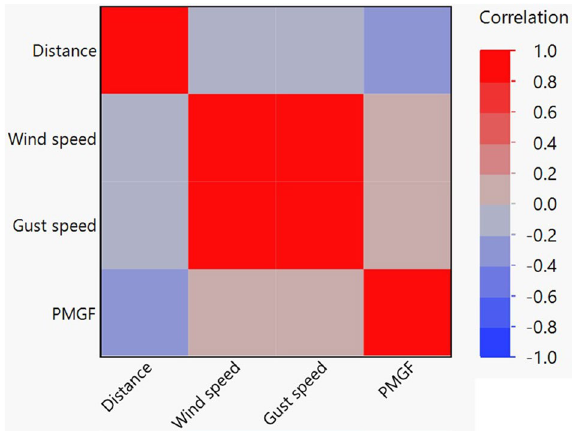
Figure 7. Map showing correlation among PMGF, distance, and the wind parameters (wind speed, gust speed) in field gene flow experiments conducted across three environments: Environment 1, Jun–July, 2018; Environment 2, October–November, 2018; and Environment 3, August–September, 2019. PMGF pollen mediated gene flow.